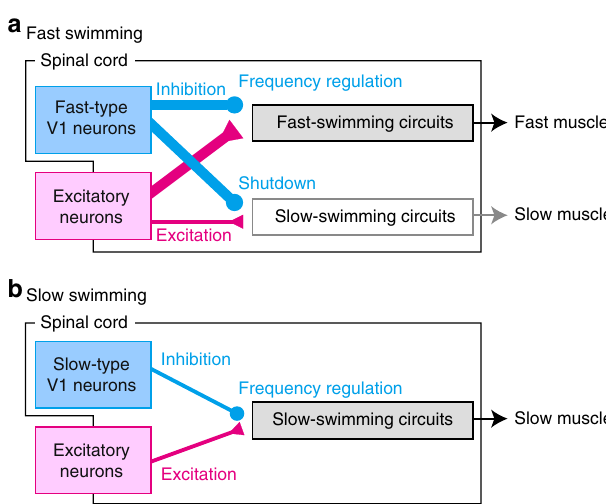
Fig. 7 Proposed model of the functions of V1 neurons. a During fast swimming, excitatory neurons (pink) provide strong phasic excitation to fast-swimming circuits (thick pink line). Excitatory neurons (pink) also provide moderate phasic excitation to fast-swimming circuits (thin pink line). Fast-type V1 neurons provide strong phasic inhibition to both of the circuits (thick blue lines). The strong phasic inhibition of fast-swimming circuits plays a role in frequency regulation. The strong phasic inhibition of slow-swimming circuits plays a role in shutting down the activities of the component neurons. b During slow swimming, excitatory neurons (pink) provide phasic excitation to slow-swimming circuits (pink line). Slow-type V1 neurons provide phasic inhibition to the circuit (blue line). The